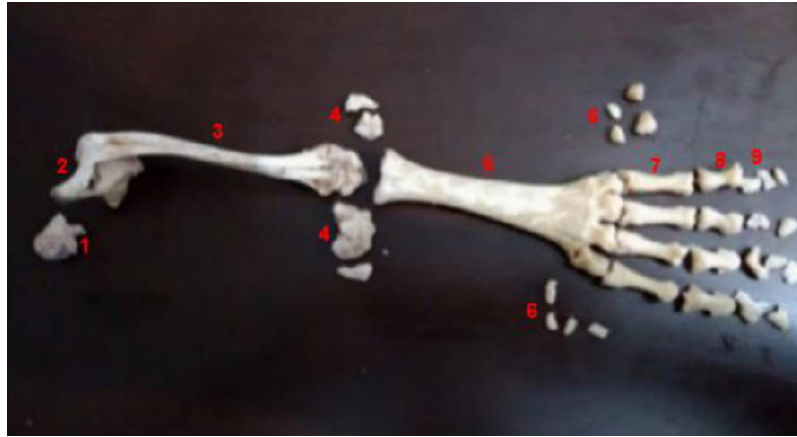
Figure 10. Bone structure of the accessory limb: (1) fibrocartilaginous structure involving the proximal region of the humerus; (2) olecranon, humerus, and head of the radius; (3) radius; (4) carpal bones; (5) metacarpal;